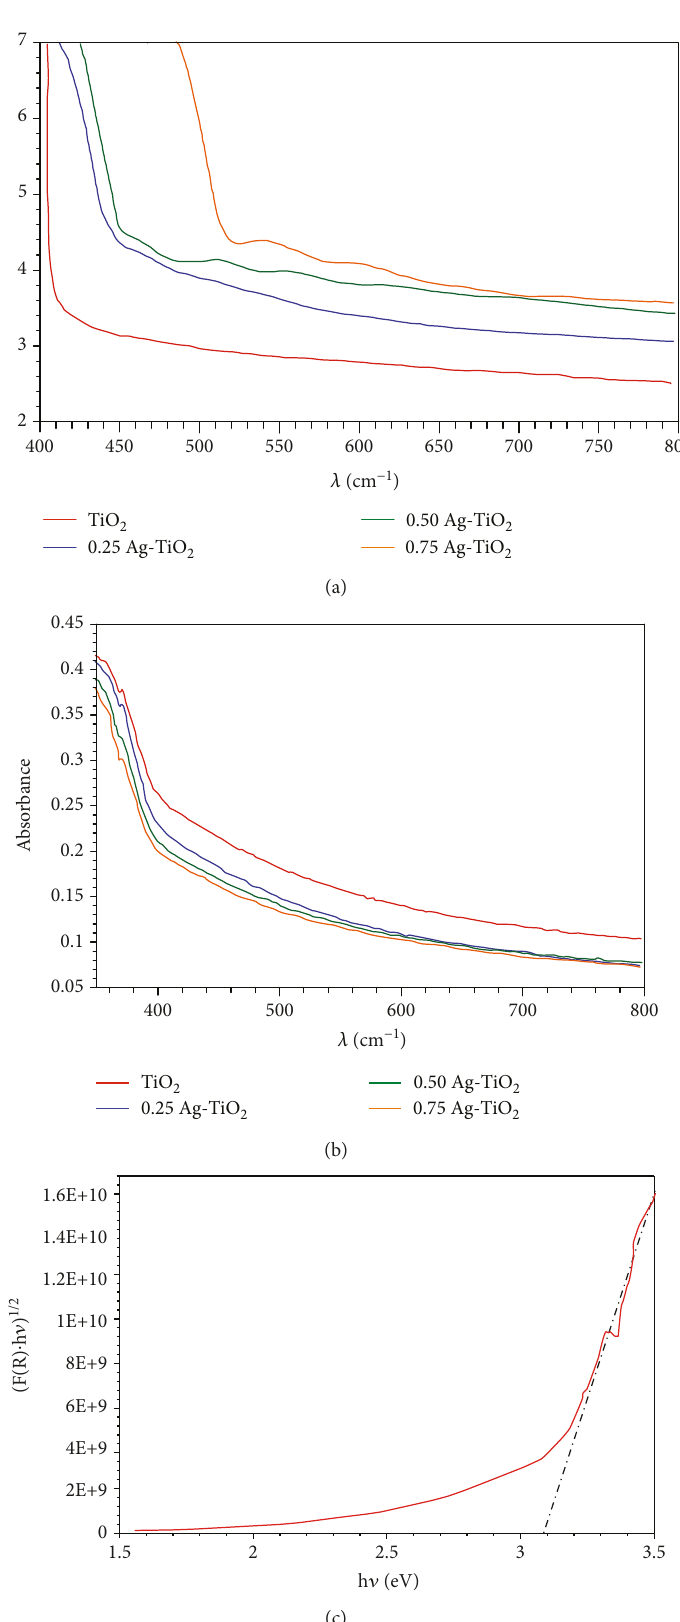
composites in powder. (b) Ag-TiO 2